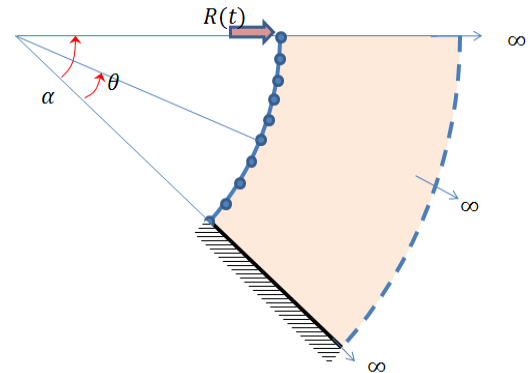
Figure 6. Reaction force R ( t ) equivalent to SSI